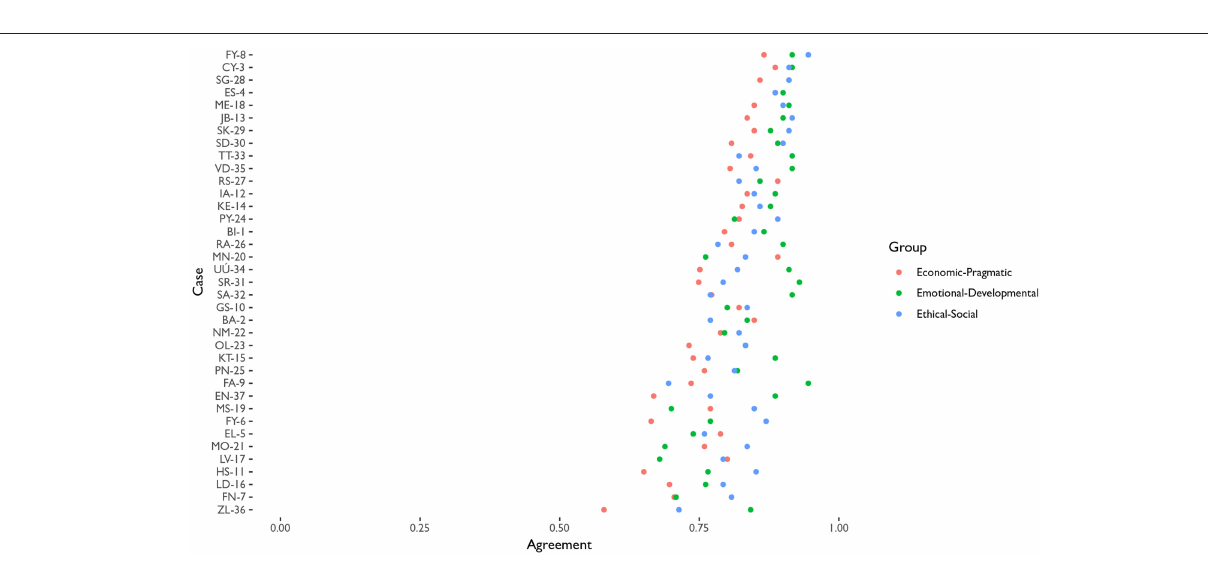
FIGURE 2 | Distribution of agreement rates between raters by case and axis of